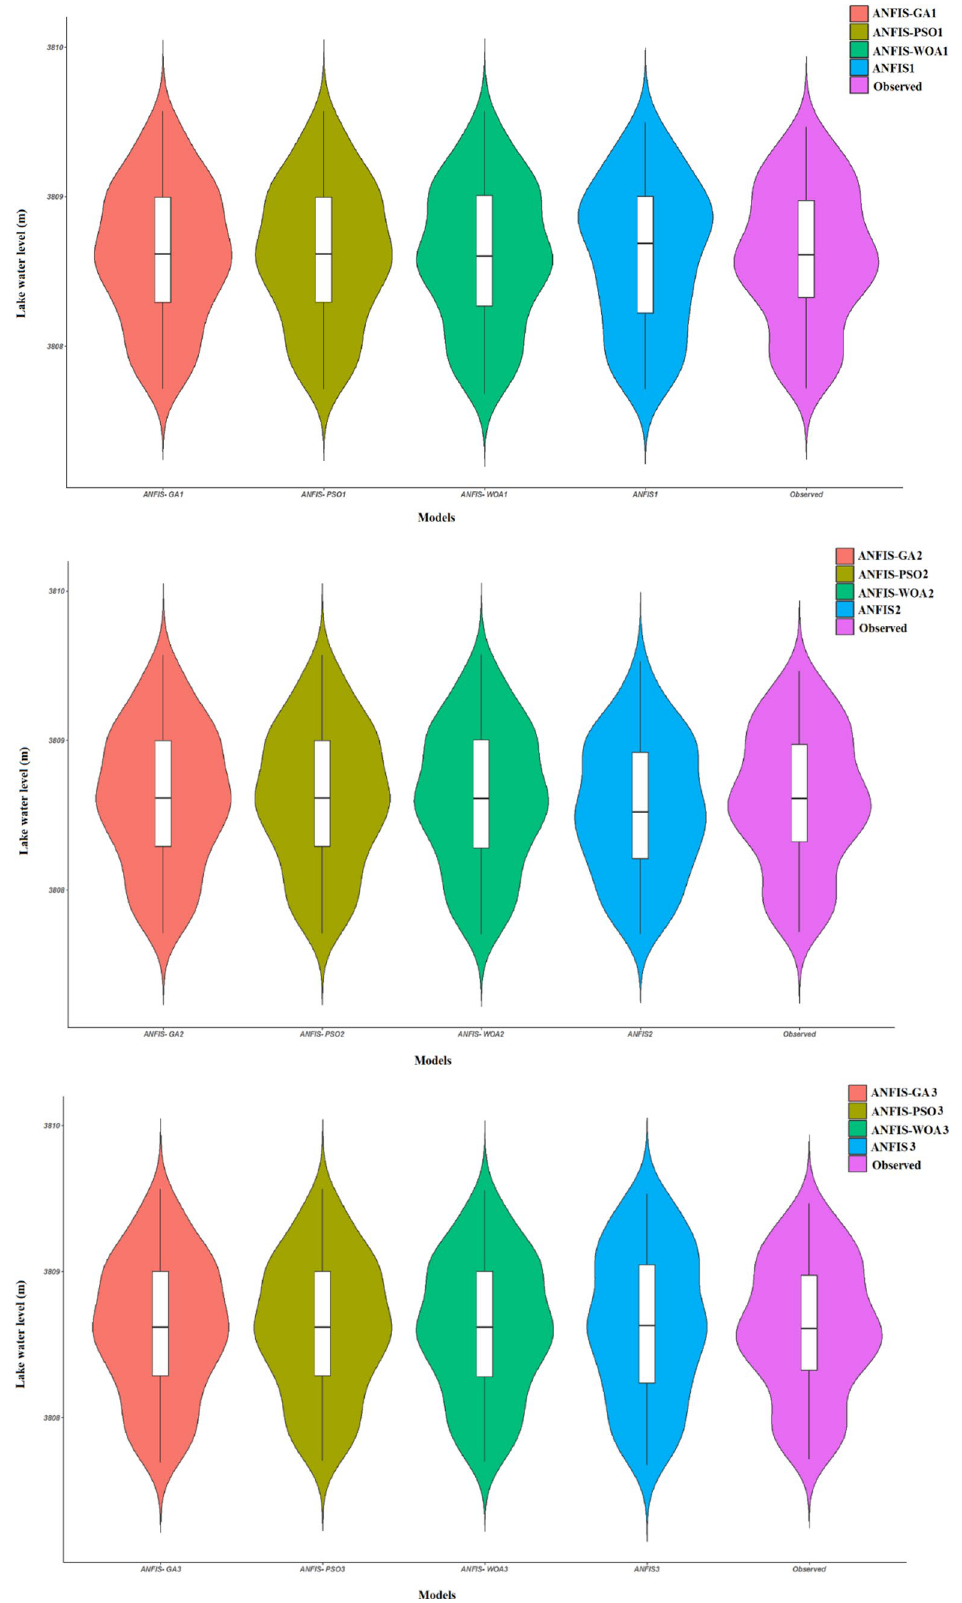
Fig. 7 Violin plot of observed and predicted lake level related to test period of all models in all